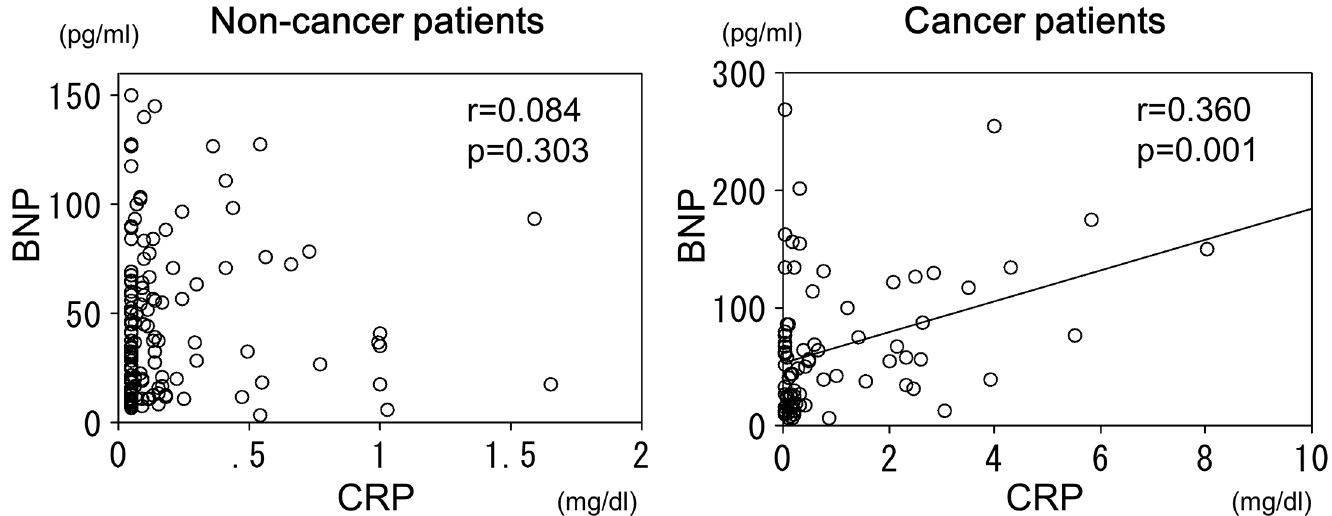
Fig 3. Relationship between BNP and CRP in patients with and without cancer. In non-cancer patients, there was no significantcorrelation between BNP and CRP levels, but there was a significantpositive correlationbetweenBNP and CRP levels in cancer patients.